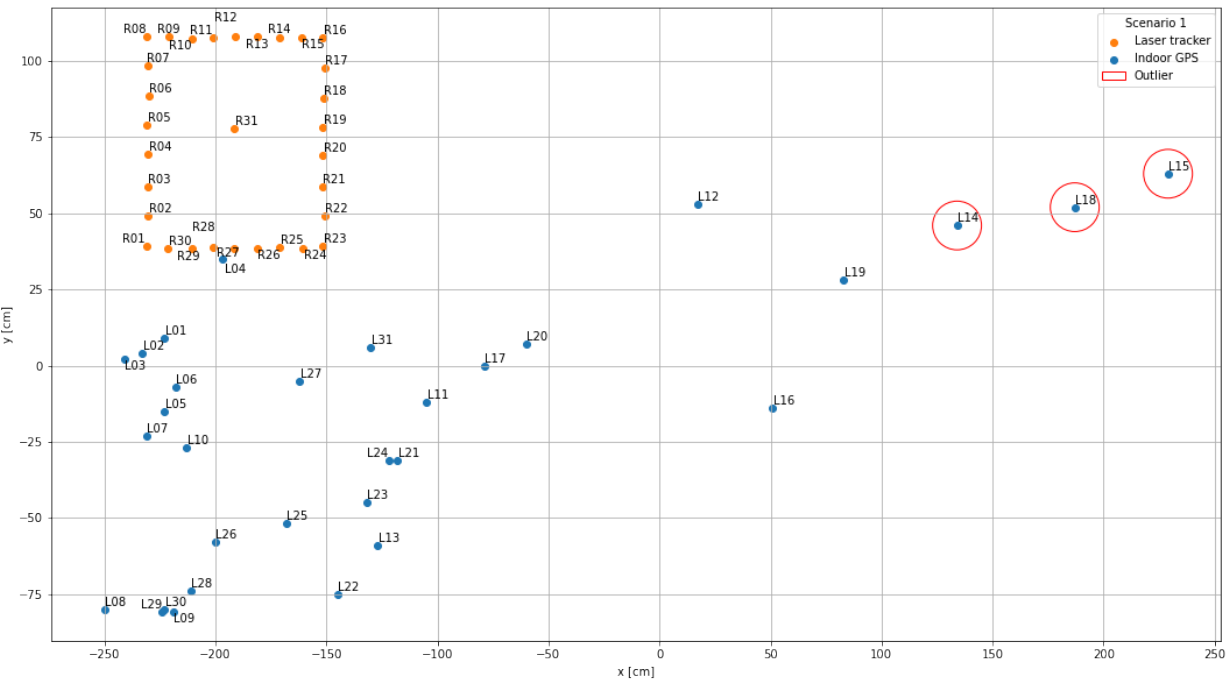
Figure 9. Data visualization scenario 1: Two lines of sight.